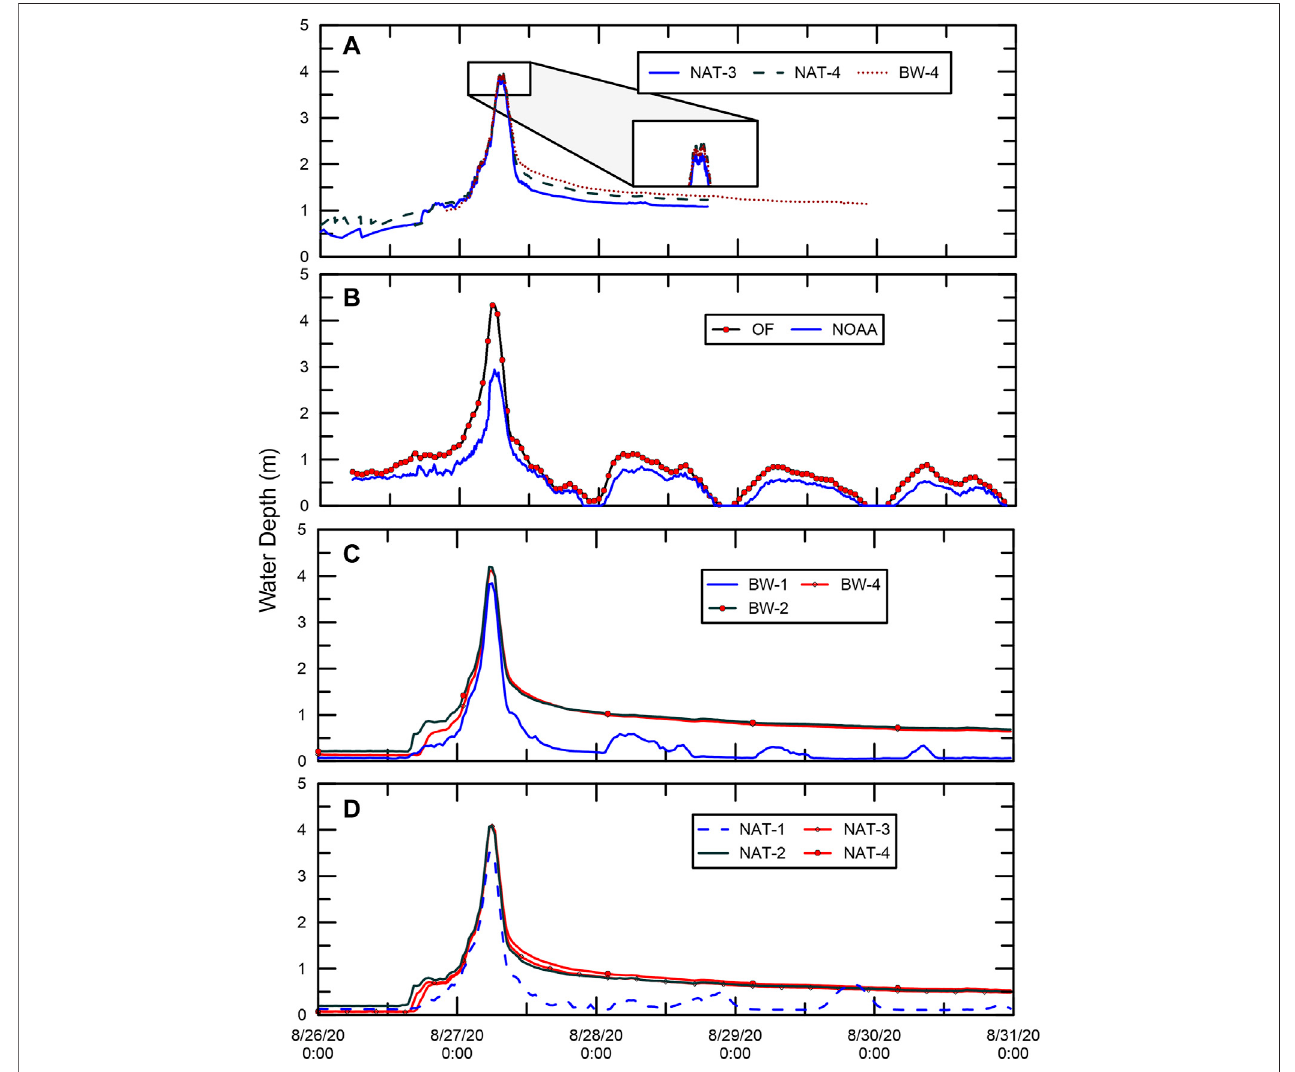
FIGURE 10 | Piezometer water levels above surface from Hurricane Laura on (A) , Offshore (OF) and NOAA Calcasieu Pass water levels (B) , water levels above surface from wave gauges on the breakwater transect (C) and on the natural transect (D) .